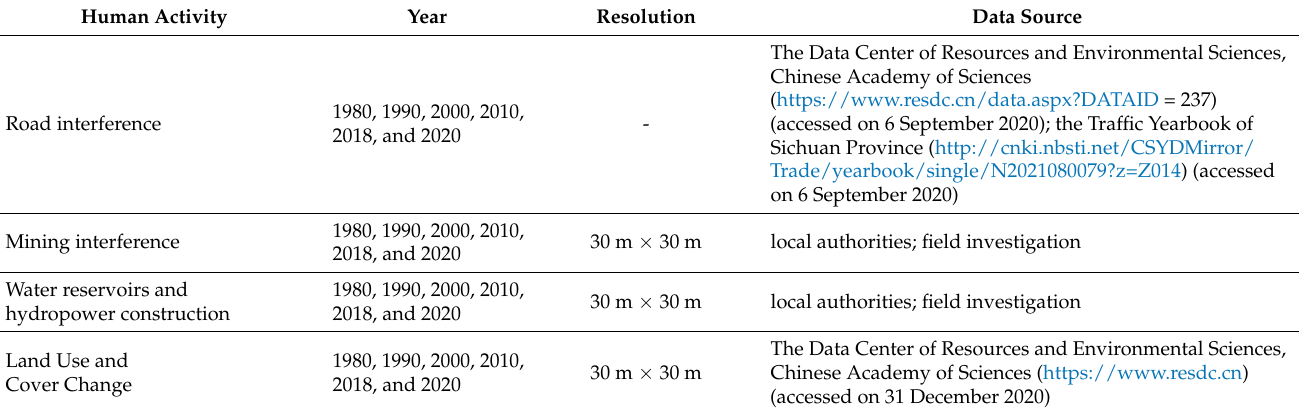
Figure 1. Research area and the Giant Panda National Park boundary. Table 1. Overview of human activity, spatial resolution, and the years of data used in the calculation of ecological